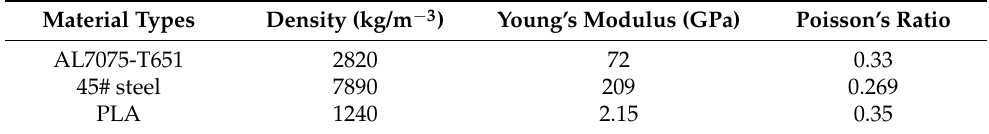
Figure 12. Two decoupled parallel XY MPSs. N and M are determined by the modules and materials of R, respectively; (a) monolithic XY stage; (b) modular XY stage.